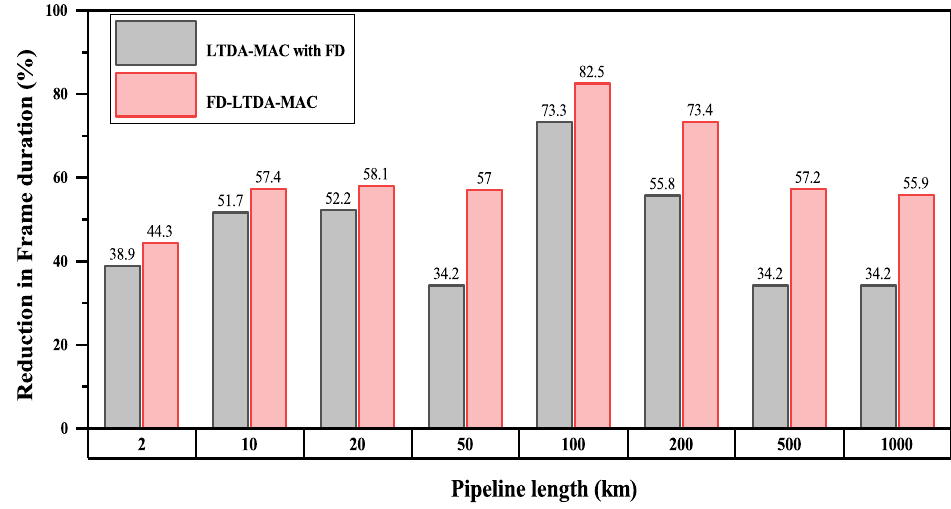
Figure 14. Percentage reduction in the Frame duration across pipeline